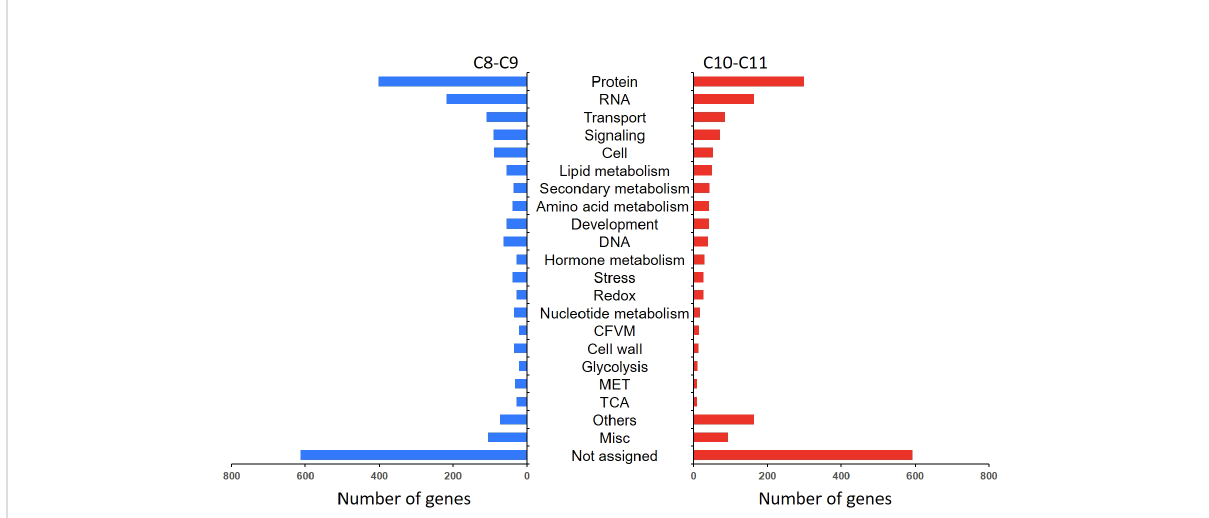
FIGURE 5 Functional category of DEGs in cluster 8 (C8), C9, C10, and C11. Gene function was predicted and categorized using MapMan bin codes. CFVM, Co-factor and vitamine metabolism; MET, mitochondrial electron transport; Others: Biodegradation of Xenobiotics, C1-metabolism, fermentation, major carbohydrate metabolism, metal handling, minor carbohydrate metabolism, oxidative pentose phosphate, polyamine metabolism, photosynthesis, S-assimilation, tetrapyrrole synthesis, and transporter.